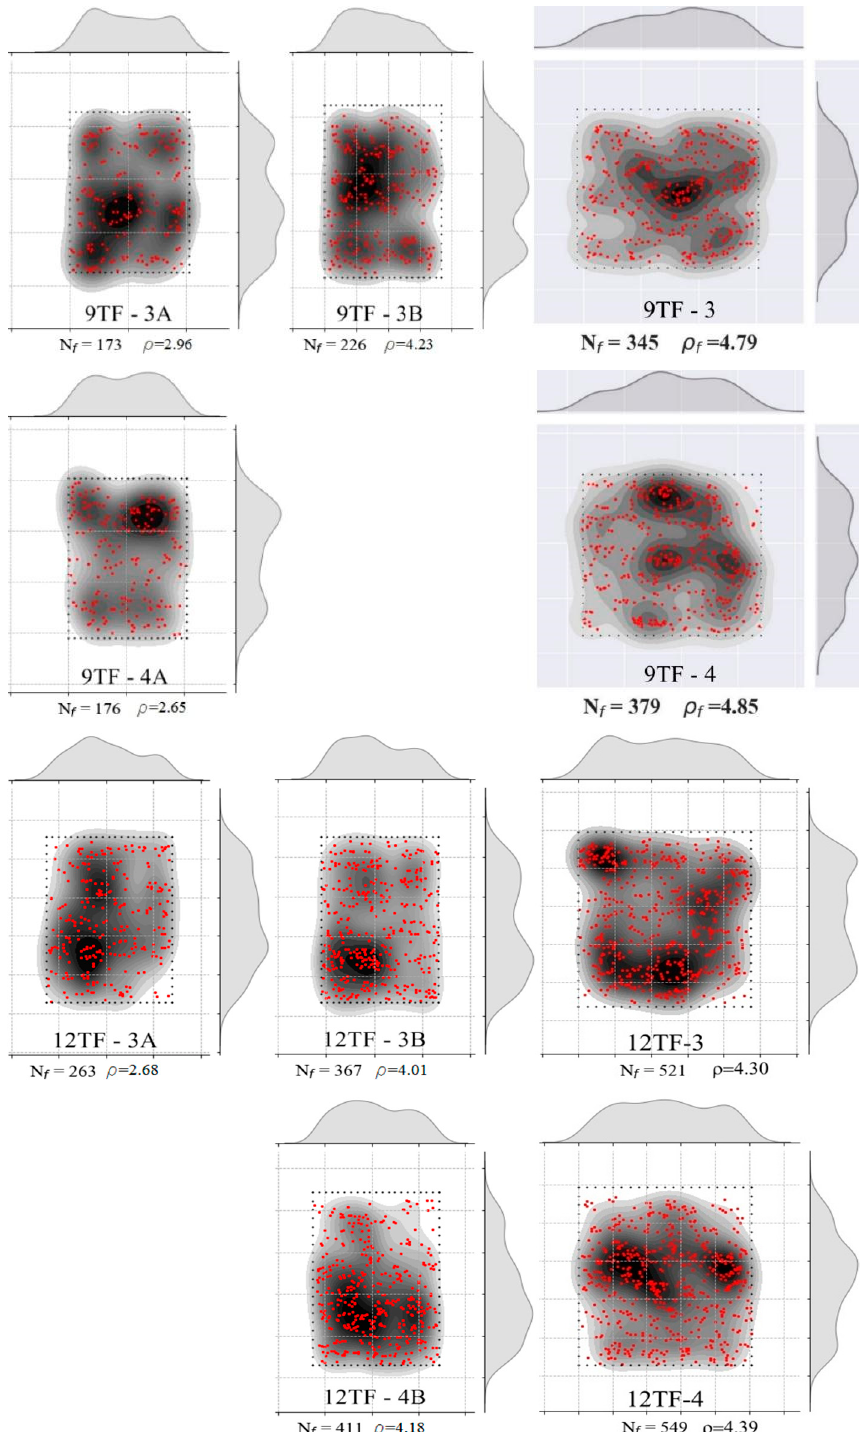
Figure 19. Fiber density and distribution of top-flange specimens of the transverse direction. Left column corresponds to prism A (shear), middle column corresponds to prism B (shear) and right column corresponds to the flexural case.